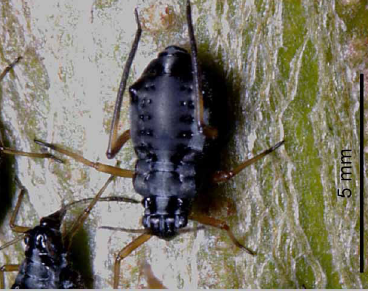
Fig. 53. Cinara (Cinara) curvipes (Patch, 1912), juvenile alata on Abies sp. (from Dransfield & Brightwell 2015, licensed under Creative Commons Attribution 3.0, downloaded 15 Sept.